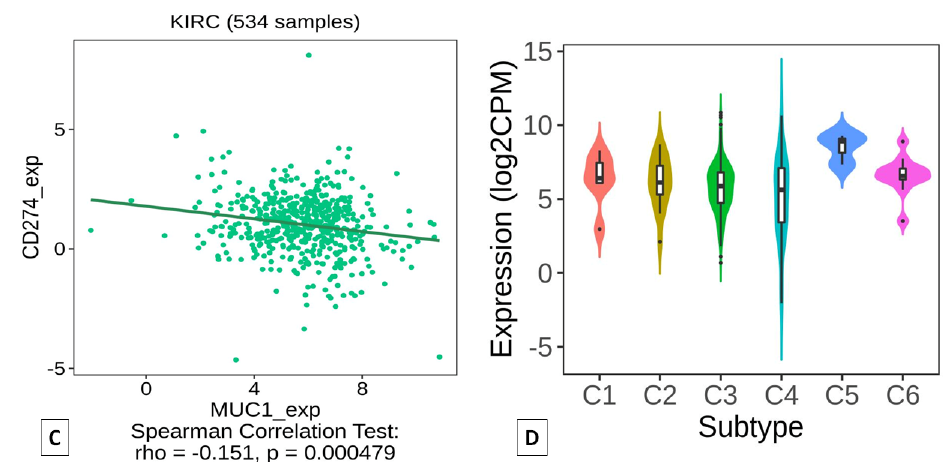
Figure 6. Correlation of MUC1 expression with infiltration level of macrophages ( A ) and mast cells ( B ) in ccRCC samples. Correlation between MUC1 and PD-L1 (CD274) expressions ( C ). Association between MUC1 expression and immune subtypes ( D ). Data were downloaded from the TISIDB web platform. Spearman’s correlation coefficients and p values are shown.